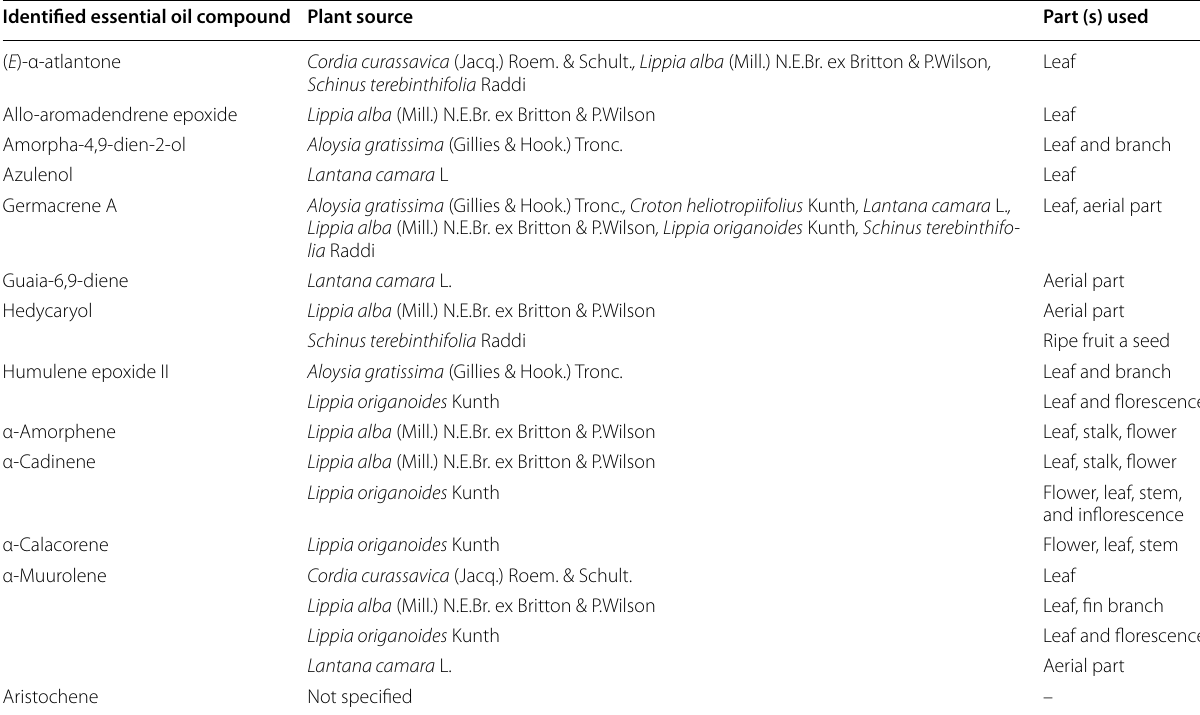
Table 4 A list of identified essential oil compounds showed anti-COVID-19 efficacy by a molecular docking study (compiled from [13] Identified essential oil compound Plant